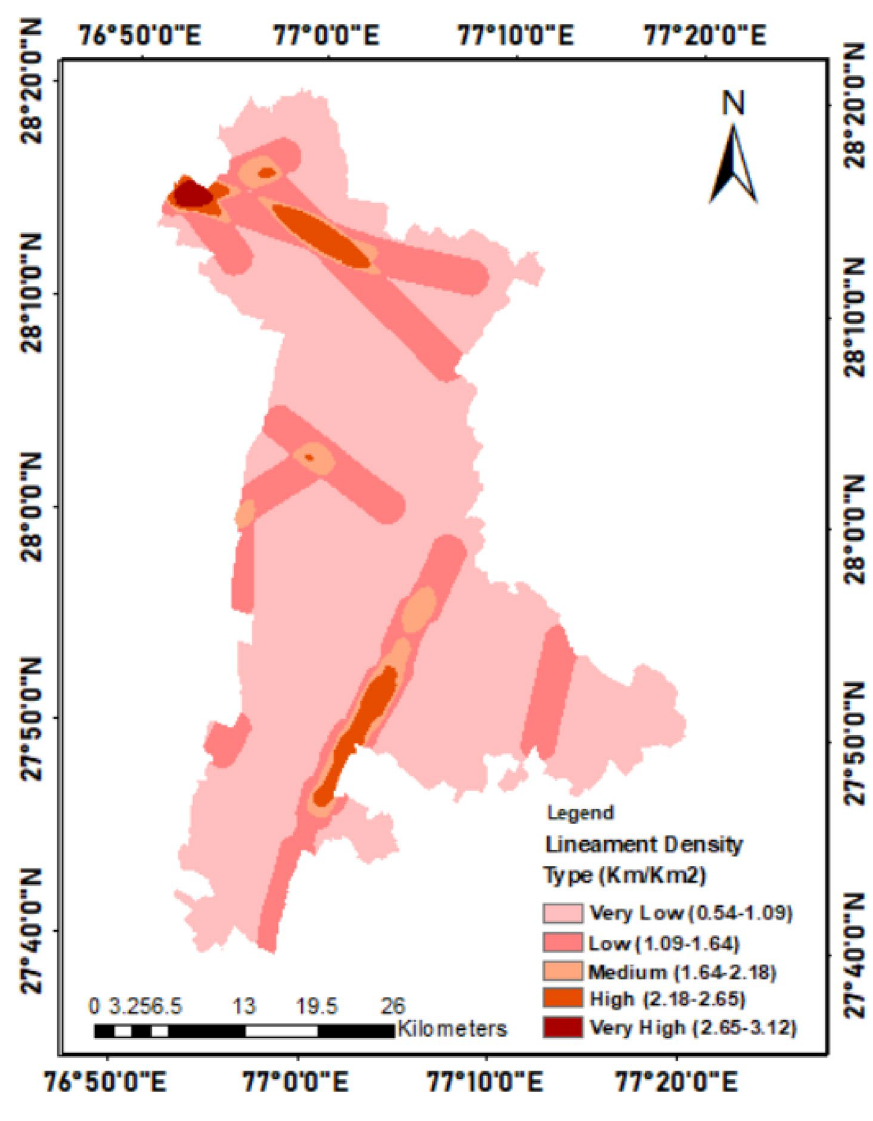
Fig. 4 Lineament density map of study